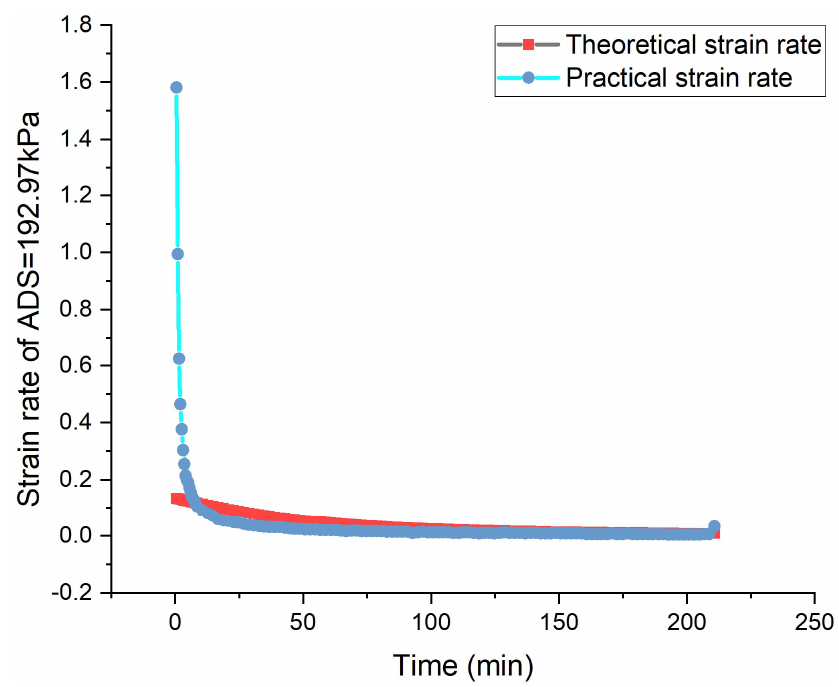
Figure 39. Comparison of theoretical and practical strain rate–time of ADS = 192.97 kPa of Specimen 23. From the three figures, the strain rate calculated from the theoretical formula Equation (25) is always lower than the practical strain rate. So, the empirical model is not accurate enough at predicting the strain rate. However, in general, the empirical model can predict the tendency of variation in the strain rate with the increase in